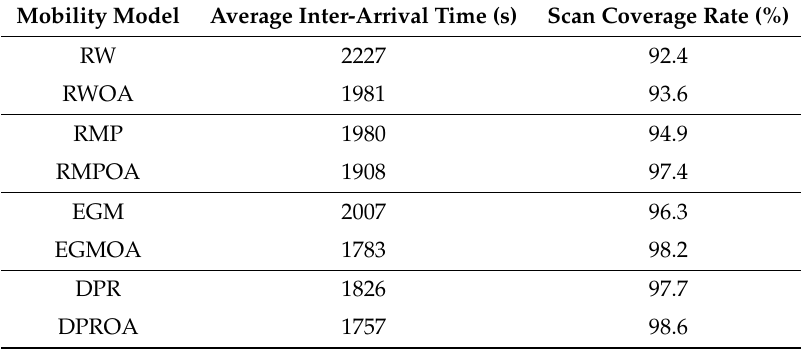
Table 6. The average inter-arrival time and scan coverage